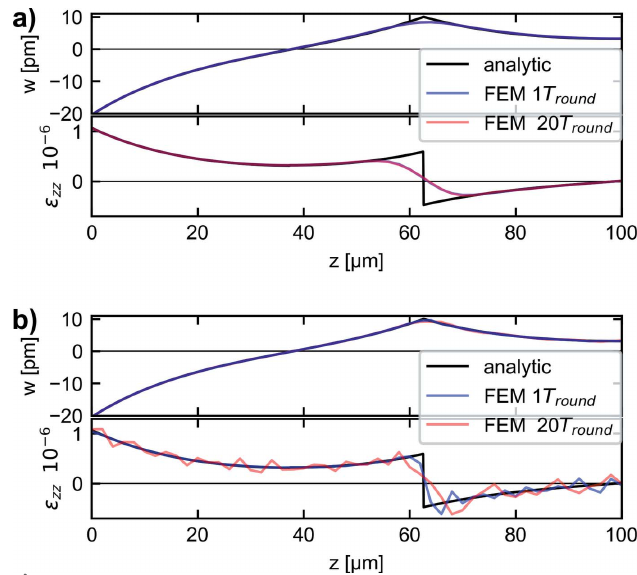
Figure 4 Comparison of analytic solution and FEM solution for displacement w and strain (cid:7) zz of a one-dimensional wave at time t = 3.5 ns after photon– matter interaction and after t = 3.5 ns + 20 T round . ( a ) Using a temporal Gaussian profile with t p = 600 ps for the FEM simulation. ( b ) Considering an instantaneously temperature rise at t = 0